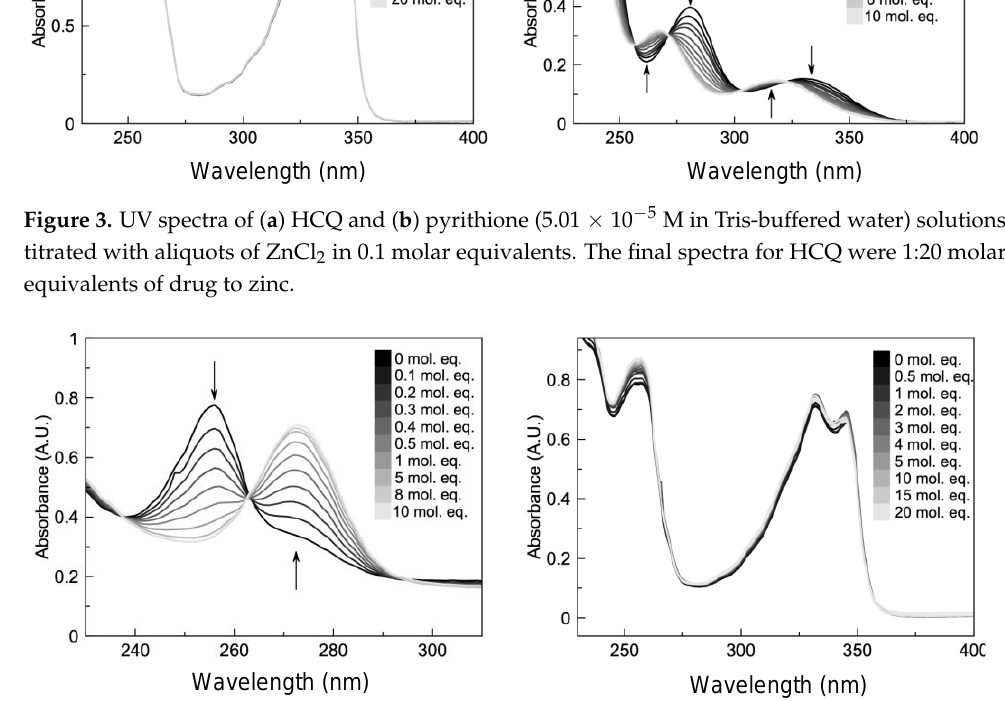
Figure 4. UV spectra of ( a ) clioquinol (CQ) and ( b ) hydroxychloroquine (HCQ) solutions (5.01 × 10 −5 M in ethanol) titrated with aliquots of ZnCl 2 in 0.1 molar equivalents. The final spectrum in each case (black line) was recorded for 1:2 (clioquinol) and 1:20 (hydroxychloroquine) molar equivalents of drug to zinc.